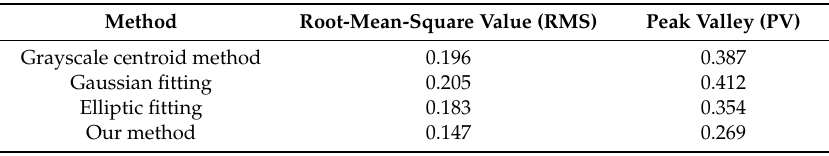
Table 1. The comparison of results for di ff erent threshold